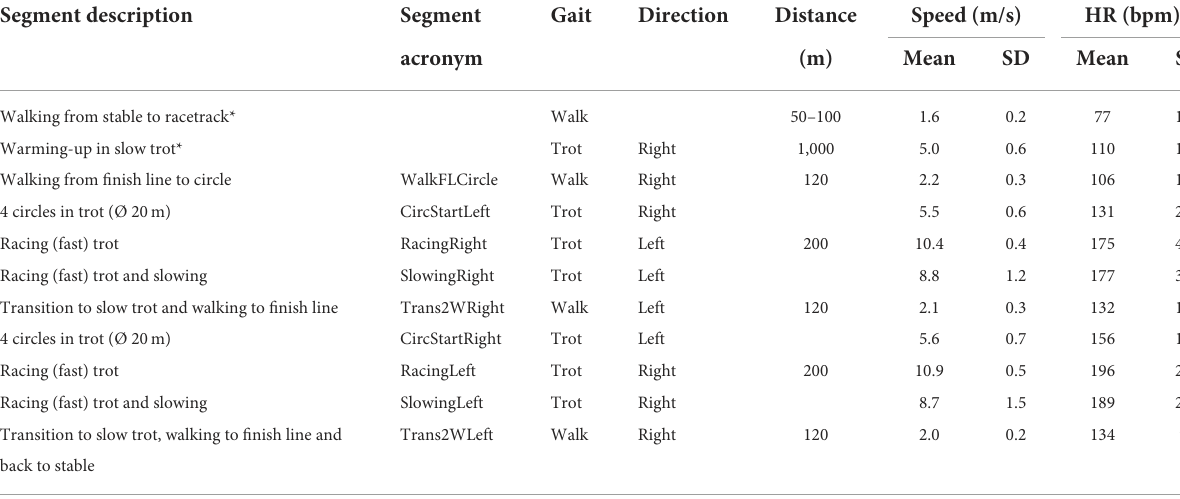
TABLE 1 Exercise protocol showing the segments studied while nine horses where driven by 11 different drivers (total 31 test drives) on an oval banked racetrack in both clockwise (right) and counter-clockwise (left)